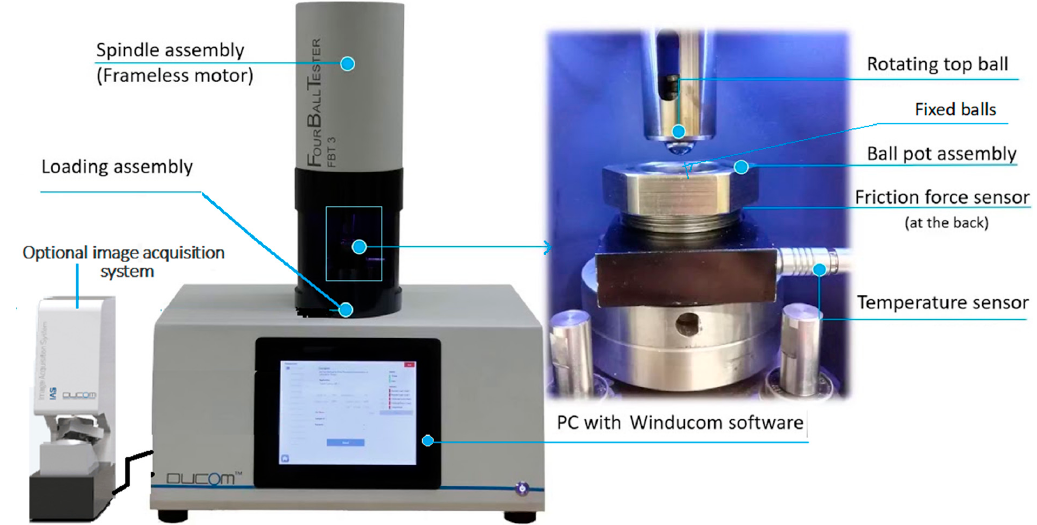
Figure 4. Schematic view of four-ball tribo tester rig.